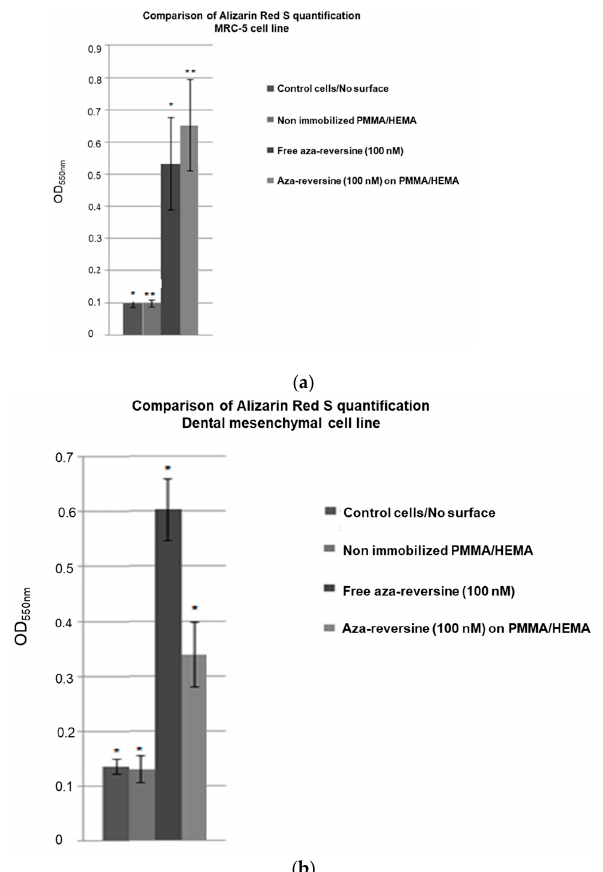
Figure 7. Alizarin red staining quantification of ( a ) MRC-5 cell reprogramming and ( b ) mesenchymal cell differentiation treated with free and with biotinylated, immobilized aza-reversine. Immobilized and free aza-reversine 2 seems to have a similar effect on MRC-5 cells, while the activity of immobilized aza-reversine is decreased on mesenchymal cells. (Student’s t -test, n = 3, * p ≤ 0.01 statistically very important, ** 0.05 ≥ p > 0.01 statistically important).